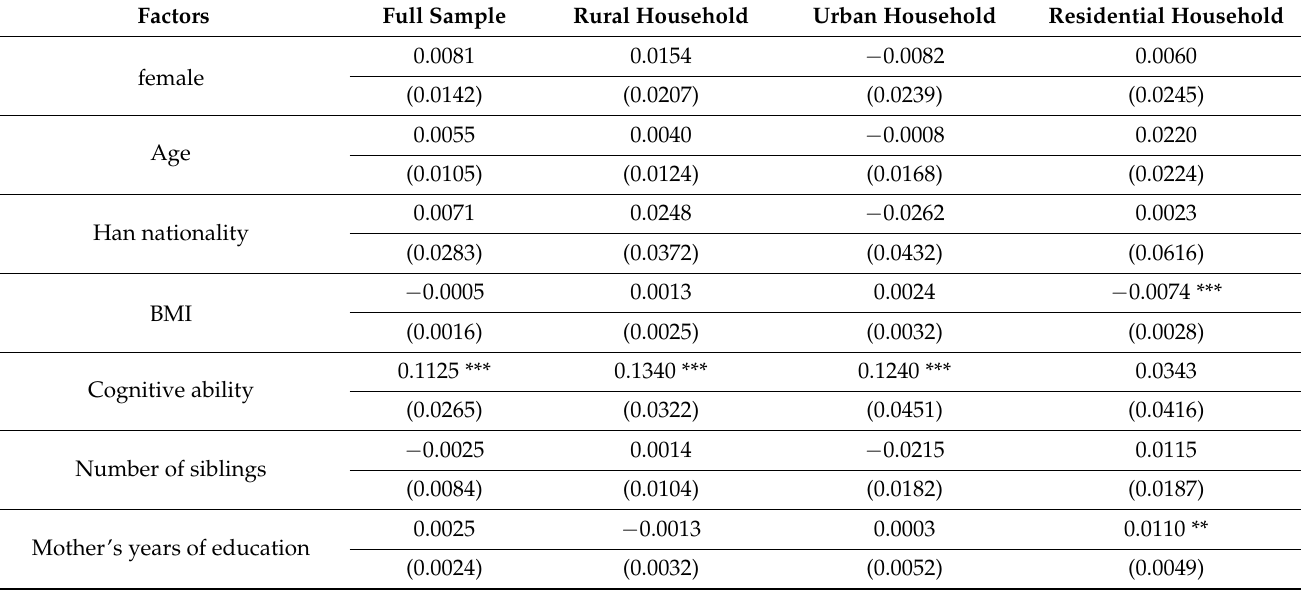
Table 4. Estimation of the tendency to participate in physical